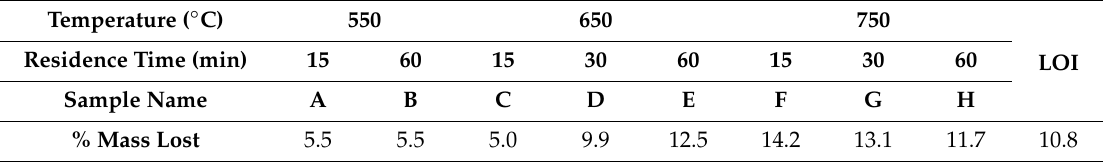
Table 4. Mass lost during each thermal treatment, expressed as percent of initial mass of sample.